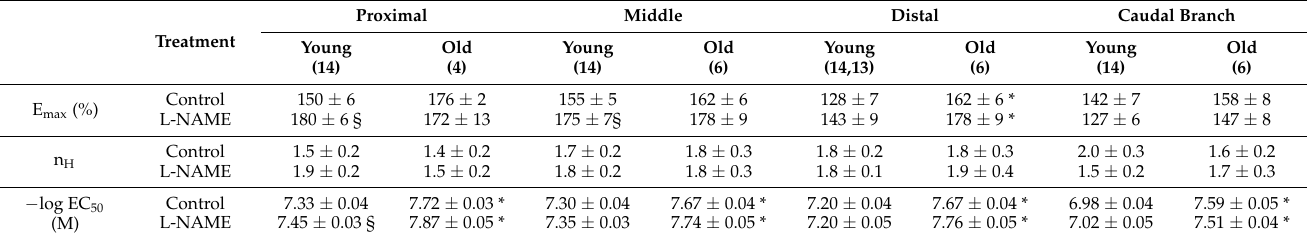
Table 3. The effect of pretreatment with L-NAME (100 µ M) on U46619 concentration–response curves in the saphenous artery segments and caudal branches from young and old Sprague Dawley rats.